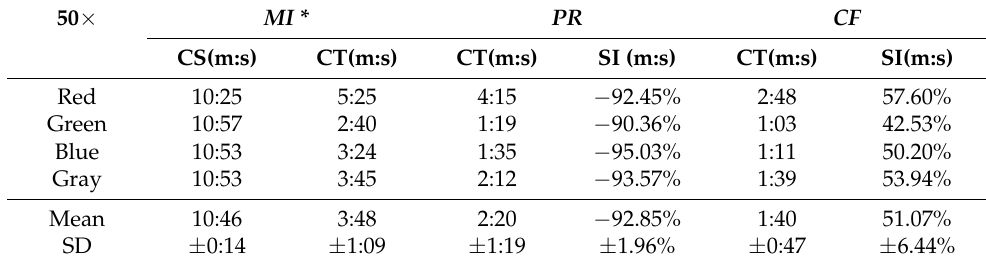
Table 4. CS, CT and SI for mean intensity MI* , plasma reduction PR and clot formation CF ∗ in the 50.